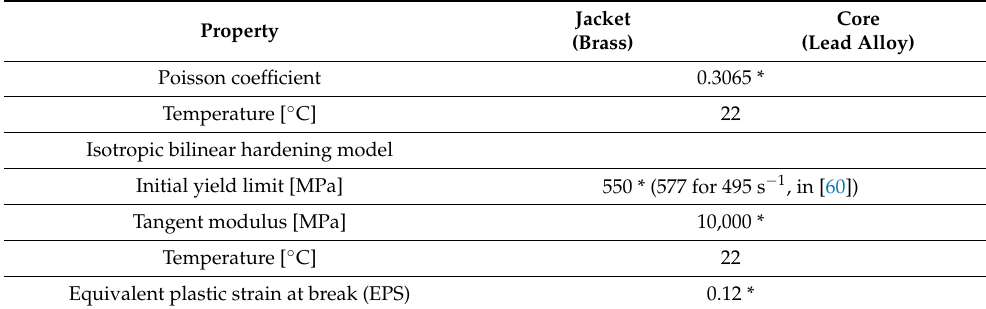
Equivalent plastic strain at break (EPS) 0.12 *